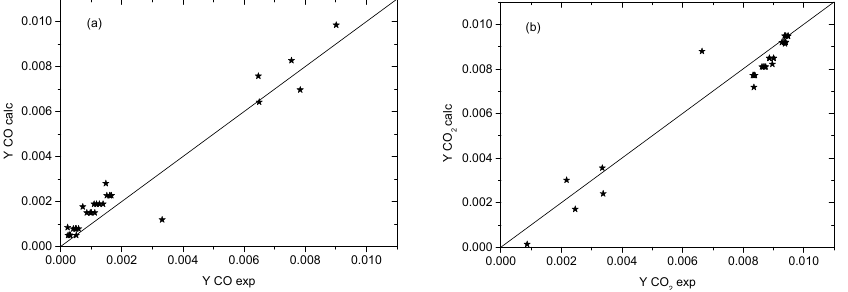
Figure 7. The parity plot of the calculated and experimental data on the outlet concentration (in mole fraction) of the fixed ‐ bed reactor: ( a ) Y (CO); ( b ) Y (CO 2 ).